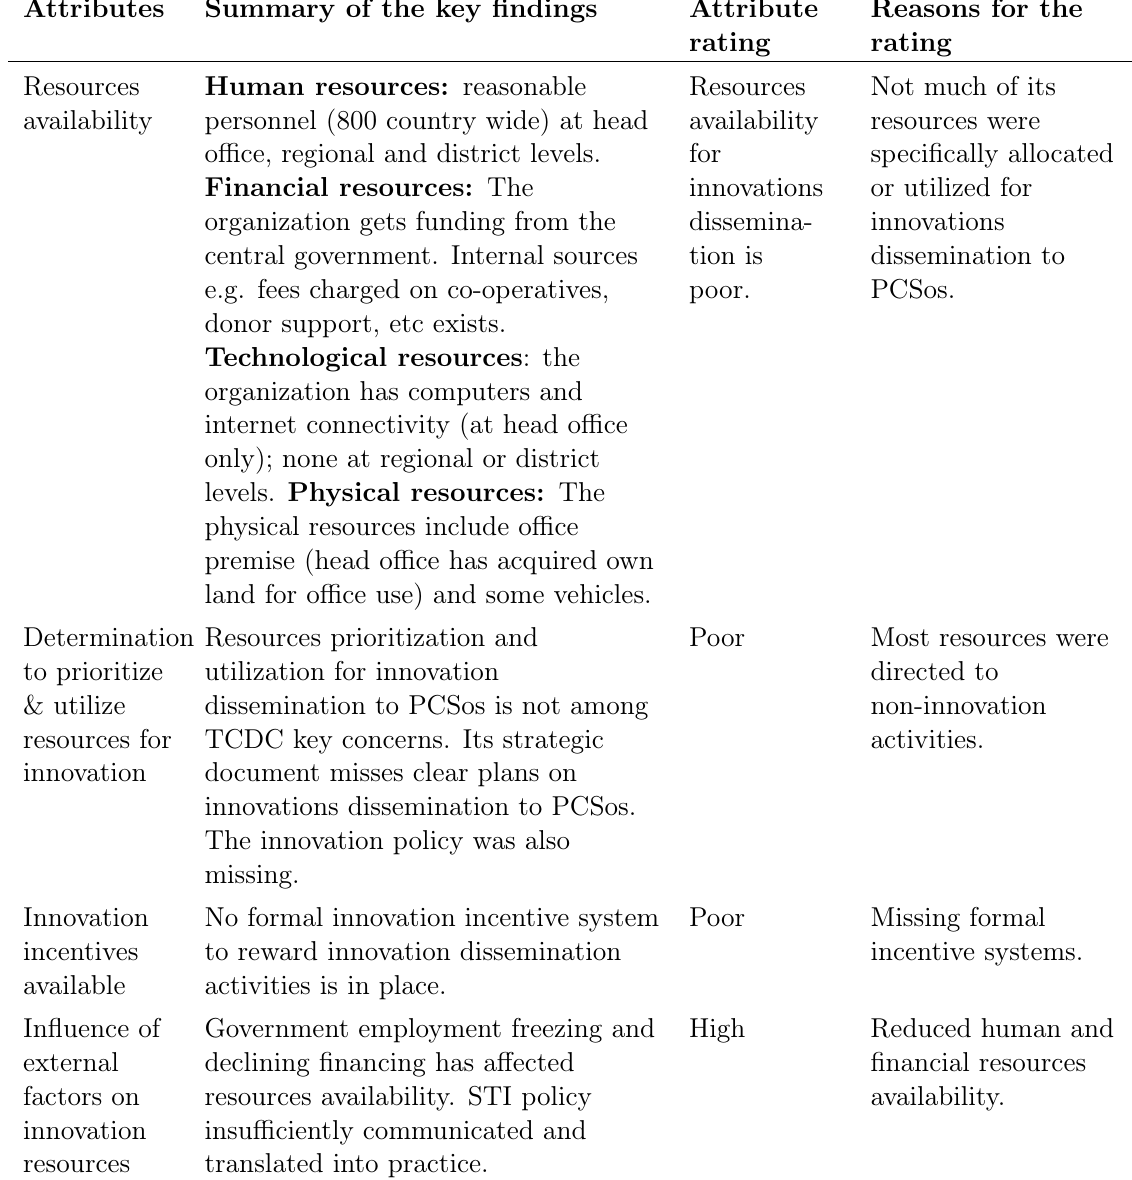
Table 2. TCDC resources capability attributes